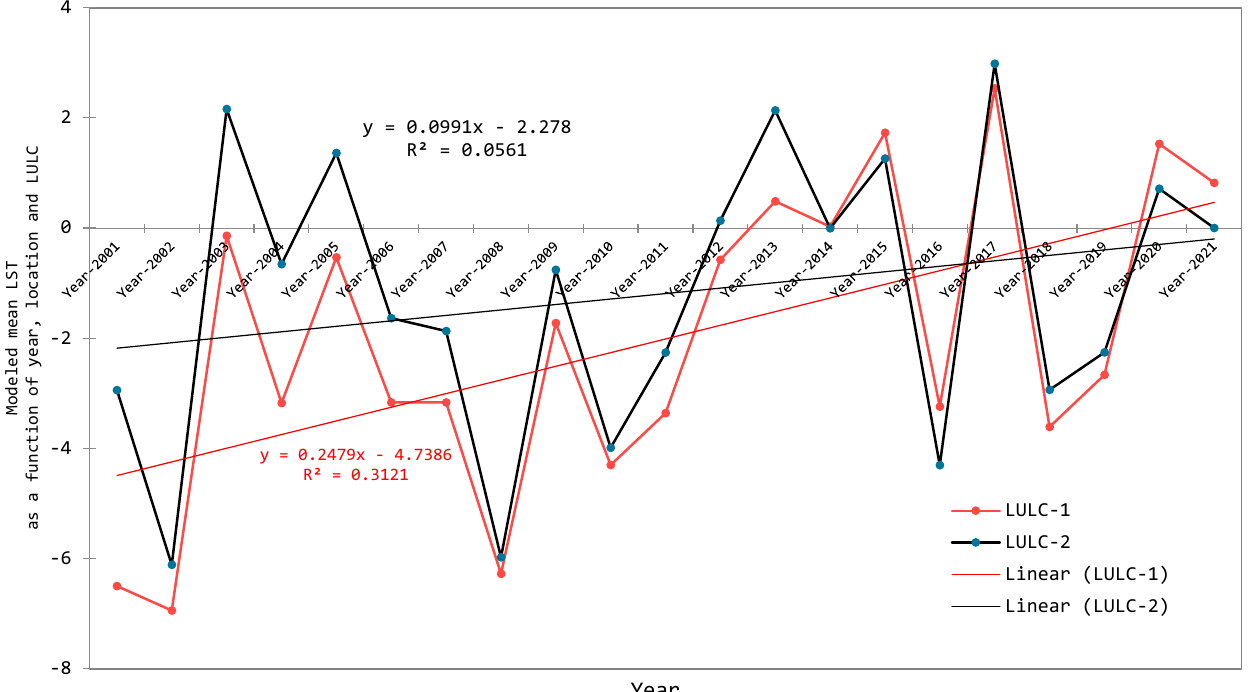
Figure 10. Modeled mean LST as a function of the interaction of time, location, and LULC calculated using linear mixed-effect model. LULC-1: urban locations; LULC-2: non-urban locations.